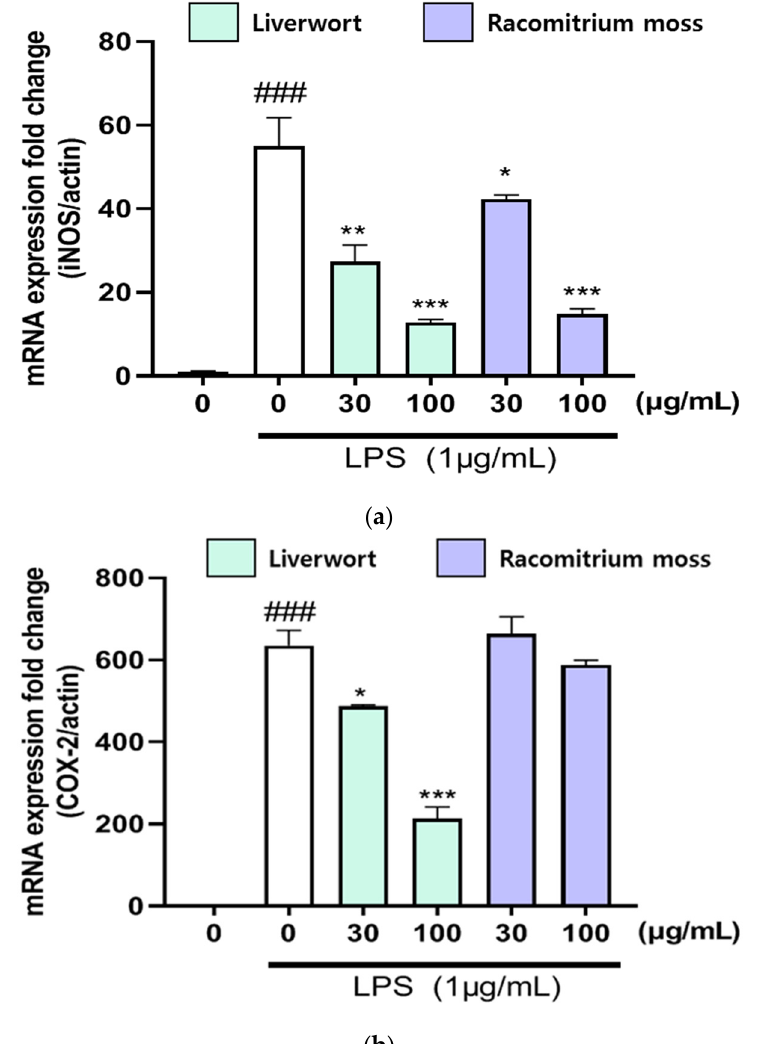
Figure 4. The effect of methanol extract of liverwort and Racomitrium moss on mRNA expressions of iNOS and COX-2 in LPS-stimulated HaCaT cells. ( a ) mRNA expression of iNOS; ( b ) mRNA expression of COX-2. Values are mean of three replicate determinations ( n = 3) ± standard deviation. ### p < 0.001 vs. 1% MeOH alone, * p < 0.05, ** p < 0.01, *** p < 0.001 vs. LPS alone.